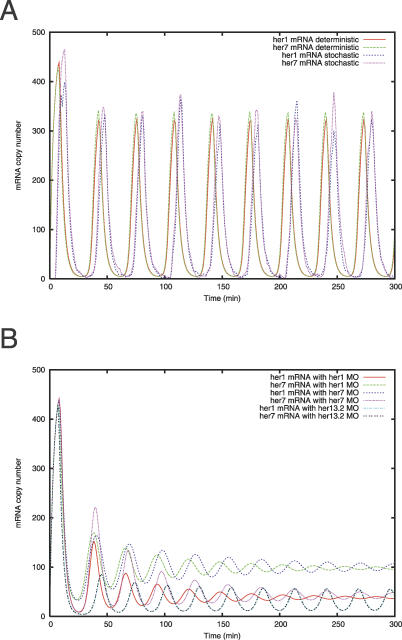
Numerical Simulations of the Model Sketched in Figure 1, without DeltaC (See Table 1 for Values of Parameters)Overlay of deterministic and stochastic simulation results (A) and deterministic simulation results with various simulated knockdowns (B).